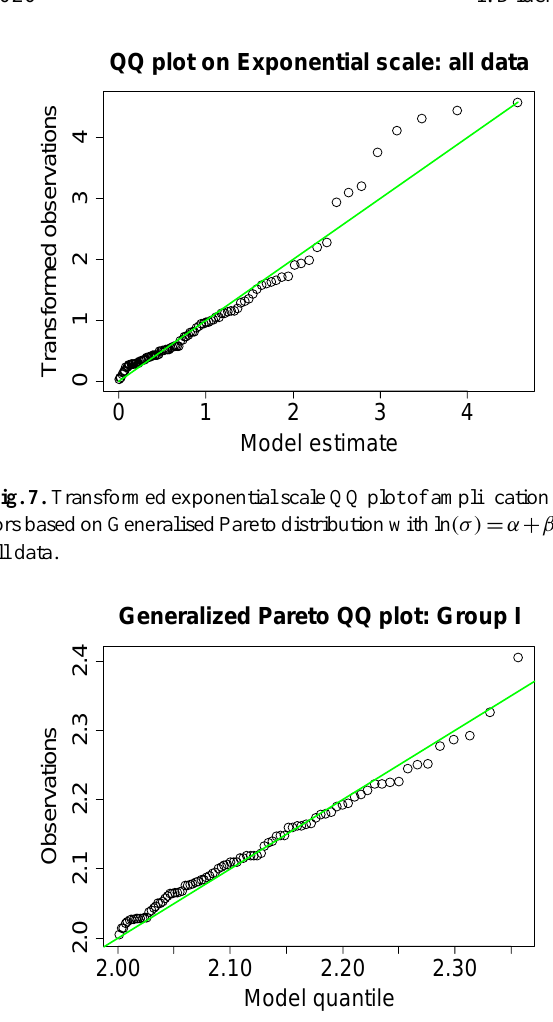
Figure 8. QQ plot of amplification factors based on a Generalized Pareto distribution with Fig. 8. QQ plot of amplification factors based on a Generalised Pareto distribution with constant parameters; Group I data. constant parameters; Group I data.